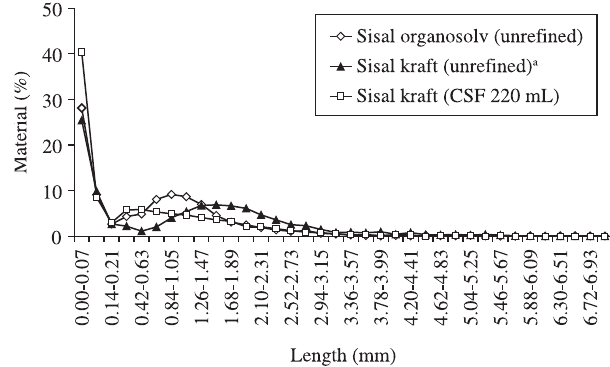
Figure 3. Length distribution of the fibrous material. ( a ) Tonoli et al. 29 .